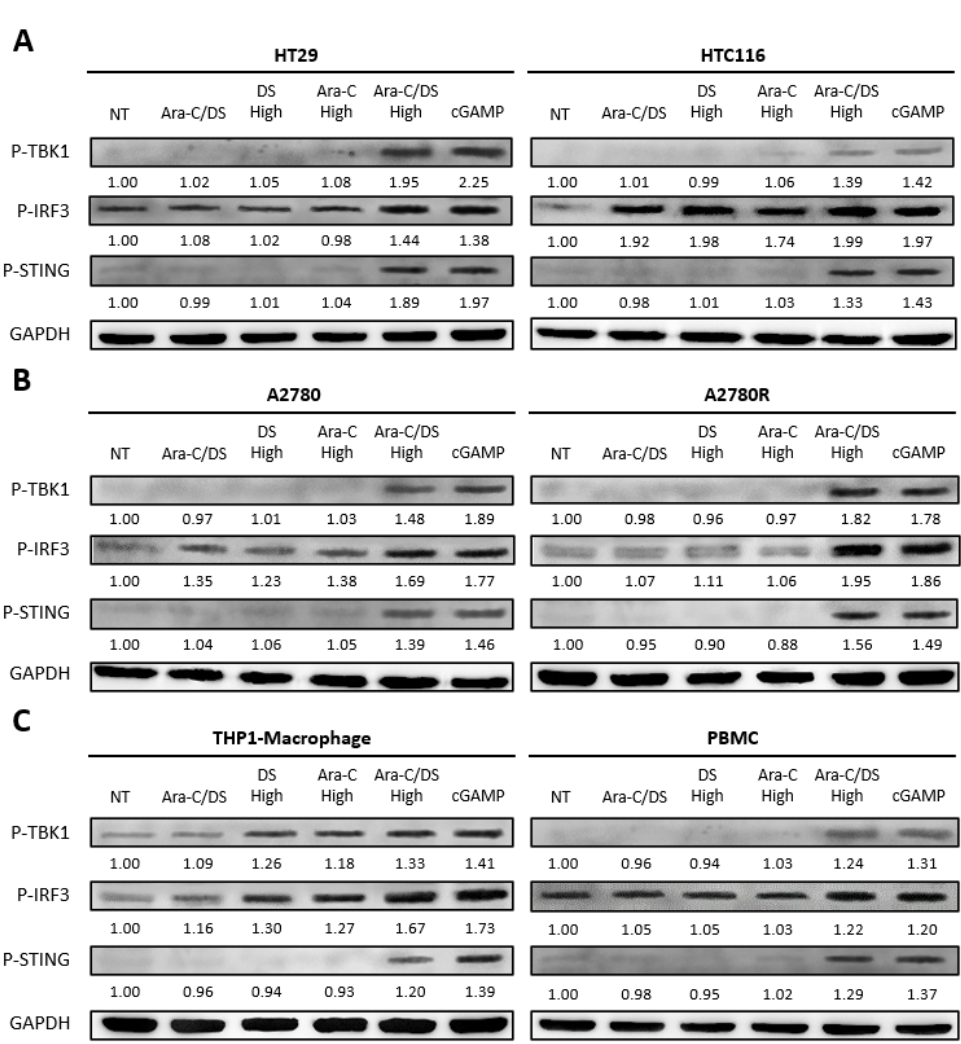
Figure 4. Assessment of cGAS-STING axis activation by Ara-C/DS and its components. Presented are immunoblots of P-TBK1, P-IRF3, P-STING, and GAPDH in ( A ) colorectal cells cell lines (HT-29 & HCT 116), ( B ) ovarian cancer cell lines (A2780 & A2780R), and ( C ) immunological cells (THP-1 derived macrophages & PBMC) after treatment for 6 h with standard dose Ara-C/DS (50 nM Ara-C, 1 µg/mL DS), high dose Ara-C (2.5 µM), high dose DS (50 µg/mL), the high dose Ara-C/DS combination (2.5 µM Ara-C, 50 µg/mL DS), or the cGAMP STING agonist (1 µg/mL) as a positive control. Results shown are representative of three replicate experiments. NT = non-treated. Densitometry values have been normalized to the GAPDH loading control, and are relative to the NT control. The uncropped bolts are shown in Supplementary Materials.